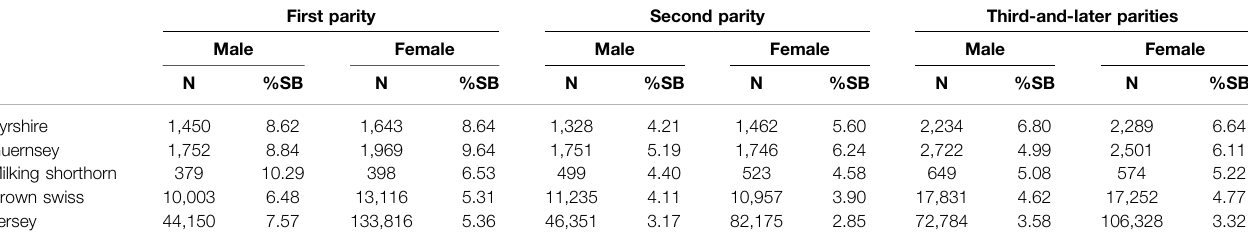
TABLE 1 | Distribution of the number of records (N) and the percentage of stillbirth (% SB) by parity-sex combination of calves in fi ve non-Holstein dairy